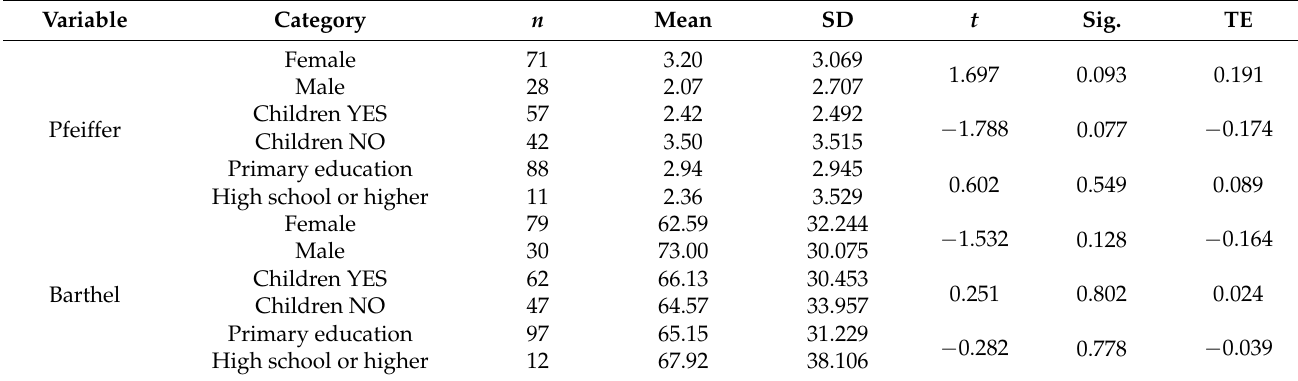
Table 4. Student’s t -test results for the scales of dependency and memory and orientation in relation to the independent variables. n =